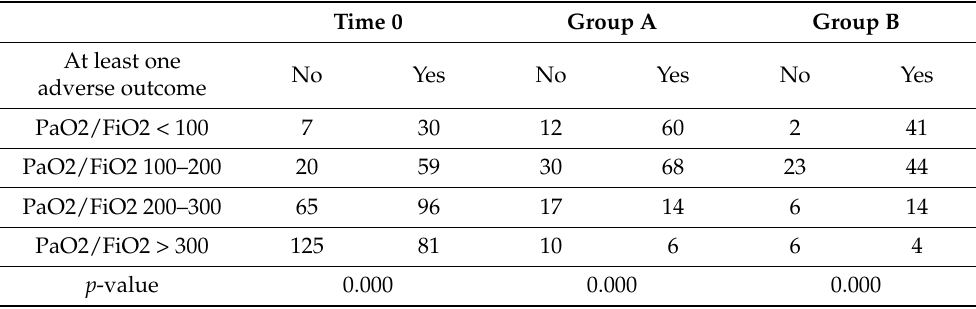
Table 3. Number of patients based on PaO2/FiO2 values at time 0, in Group A and Group B, divided into those with and without at least one adverse outcome. Time 0 Group A Group